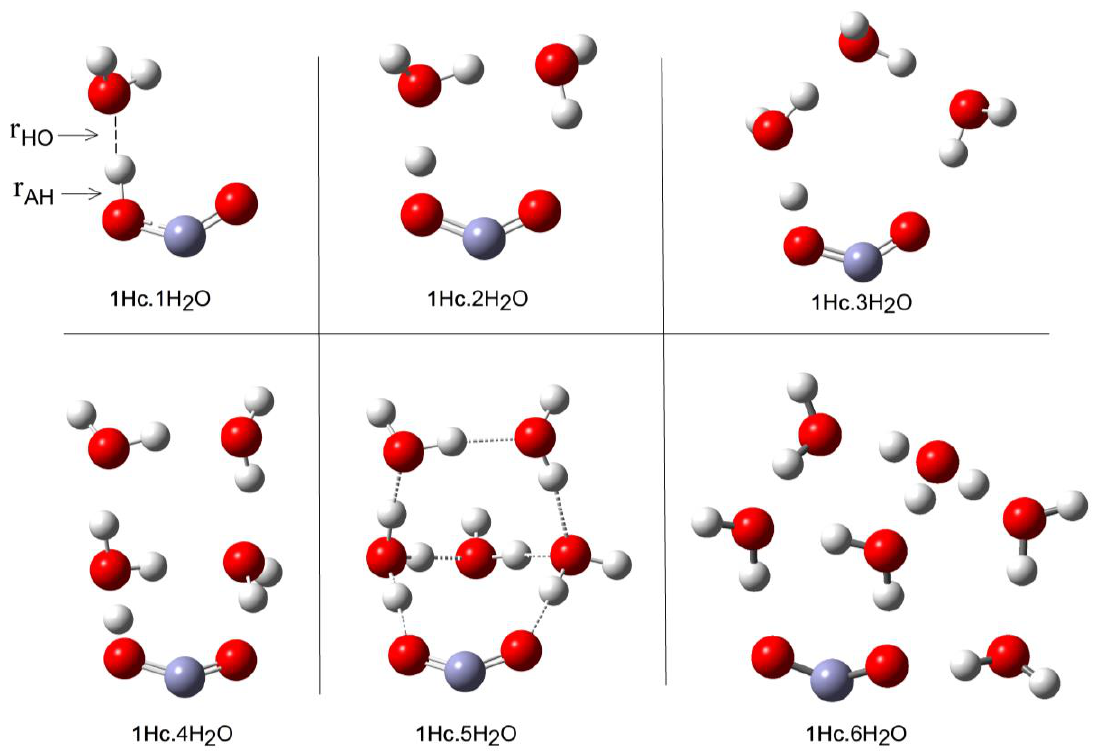
Figure 1. Optimized Cluster Structures of cis -Carboxyl ( 1Hc ) with 1 to 6 H 2 O molecules.